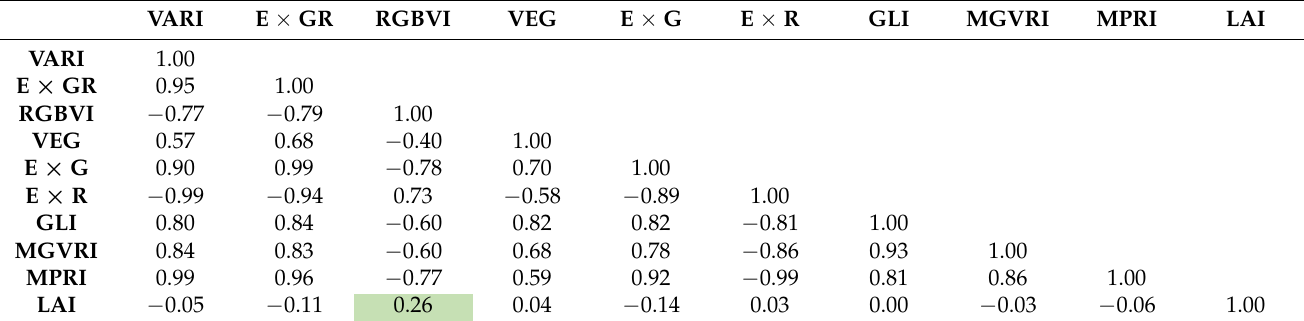
Table 3. Correlation between VIs and LAI in the third phase of the phenological cycle of the coffee.